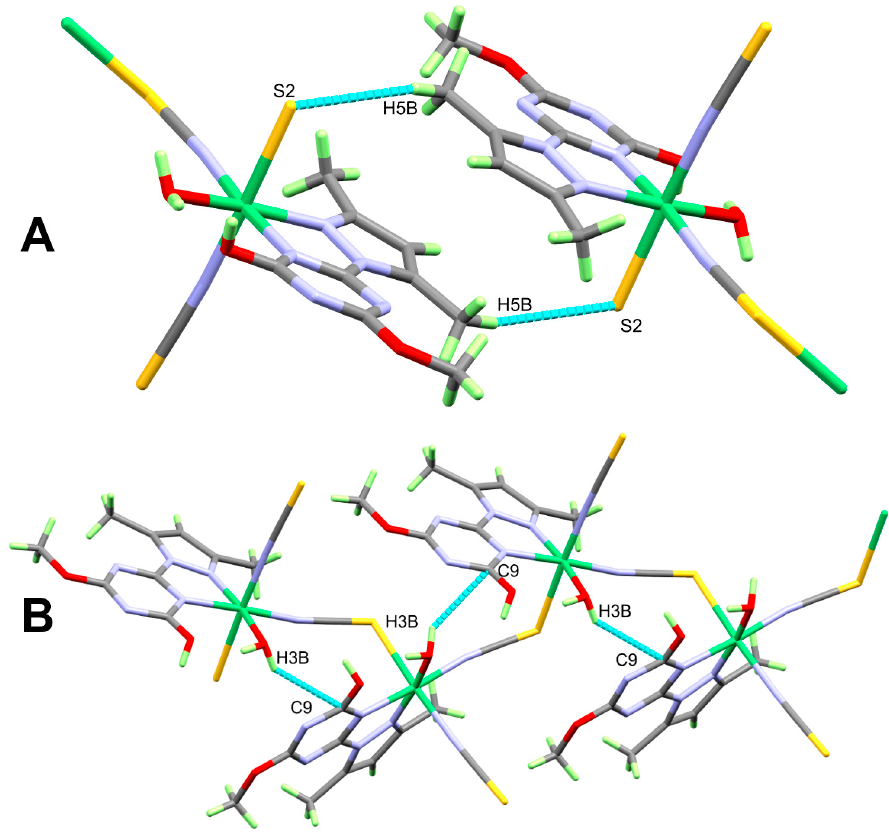
Figure 4. The C-H…S ( A ) and O-H…C ( B ) interactions connecting the 1D polymer backbone of the [Ni(MPT)(H 2 O)(SCN) 2 ] n complex. the [Ni(MPT)(H 2 O)(SCN) 2 ] n